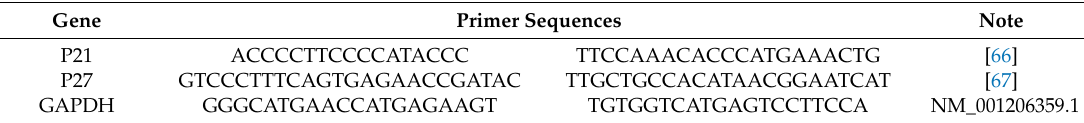
Table 2. Primer sequences for PCR